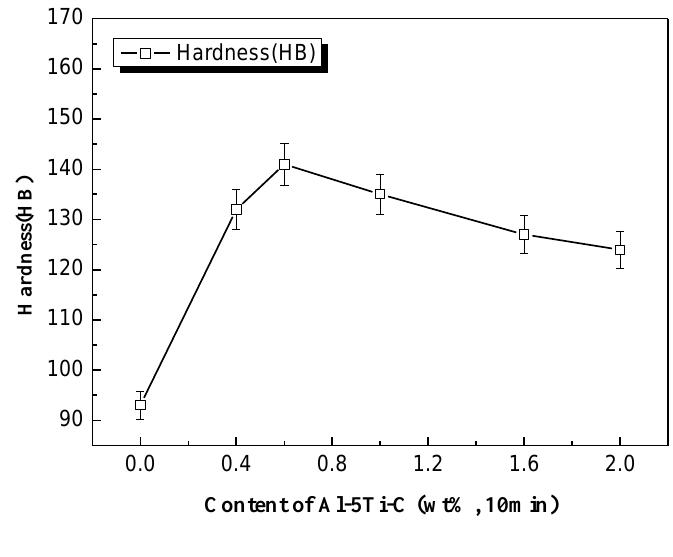
Figure 10. Brinell hardness of hypereutectic Al–20%Si alloy with various contents of Al–5Ti–C master